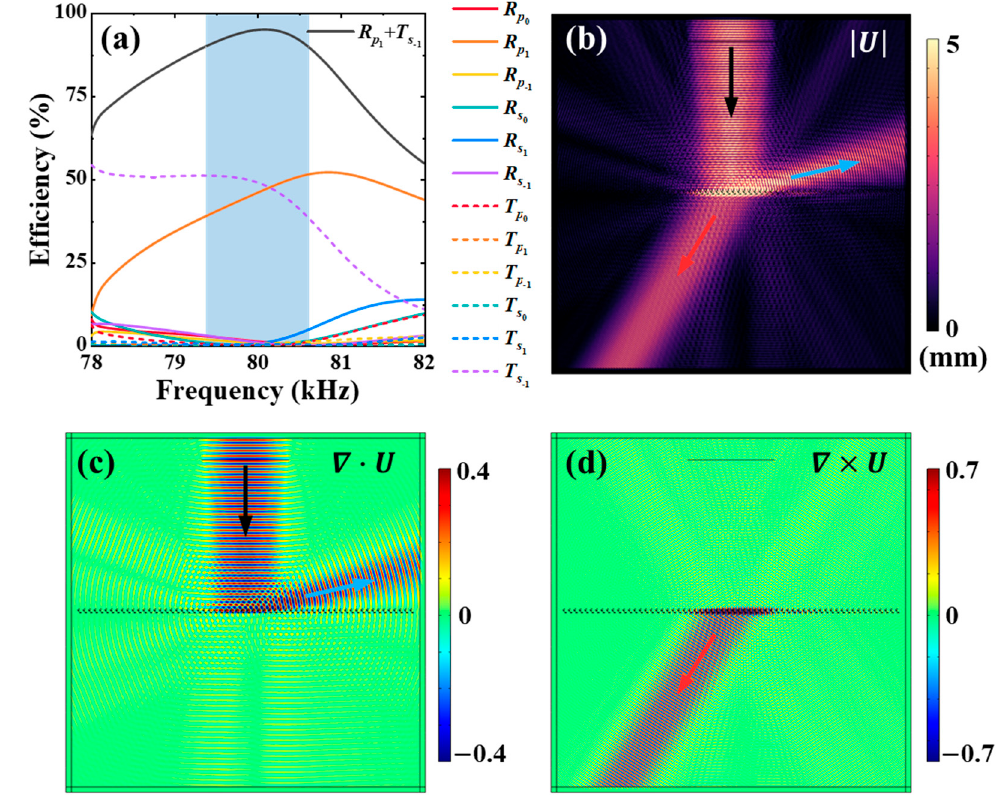
Figure 2. High-efficiency diffraction along the R p and T s channels when a p -wave is normally incident on the metagrating. ( a ) The diffraction efficiency spectra for all 12 channels, where f 0 = 80 kHz is the operating frequency; ( b ) shows the amplitude of displacement amplitude at f 0 ; ( c , d ) show the divergence and curl of the displacement field, corresponding to longitudinal and transverse wave components, respectively. Black, blue, and red arrows represent the incident p -wave, reflected p -wave, and transmitted s -wave, respectively. Table 1. Diffraction efficiency with different sizes of mesh